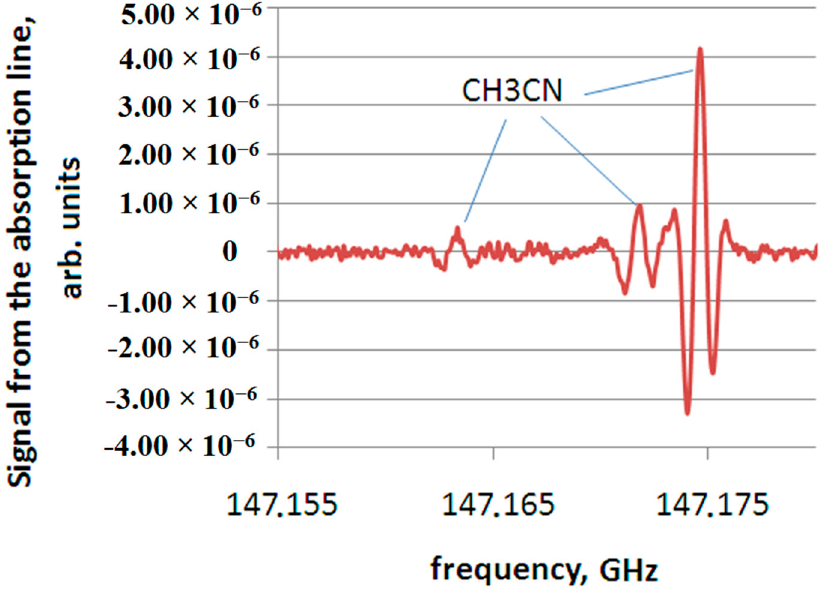
Figure 5. Example of recording a spectrum section containing acetonitrile (CH 3 CN) lines for a polyp tissue sample (No. 6) with experimentally measured central frequencies f 1exp = 147.1633 GHz (f 1cat = 147.1632441 GHz for a transition with quantum numbers 8 2 ← 7 2 [15]), f 2exp = 147.1718 GHz (f 2cat = 147.1717519 GHz for a transition with quantum numbers 8 1 ← 7 1 [15]), and f 3exp = 147.1746 GHz (f 3cat = 147.1745883 GHz for a transition with quantum numbers 8 0 ← 7 0 [15]).